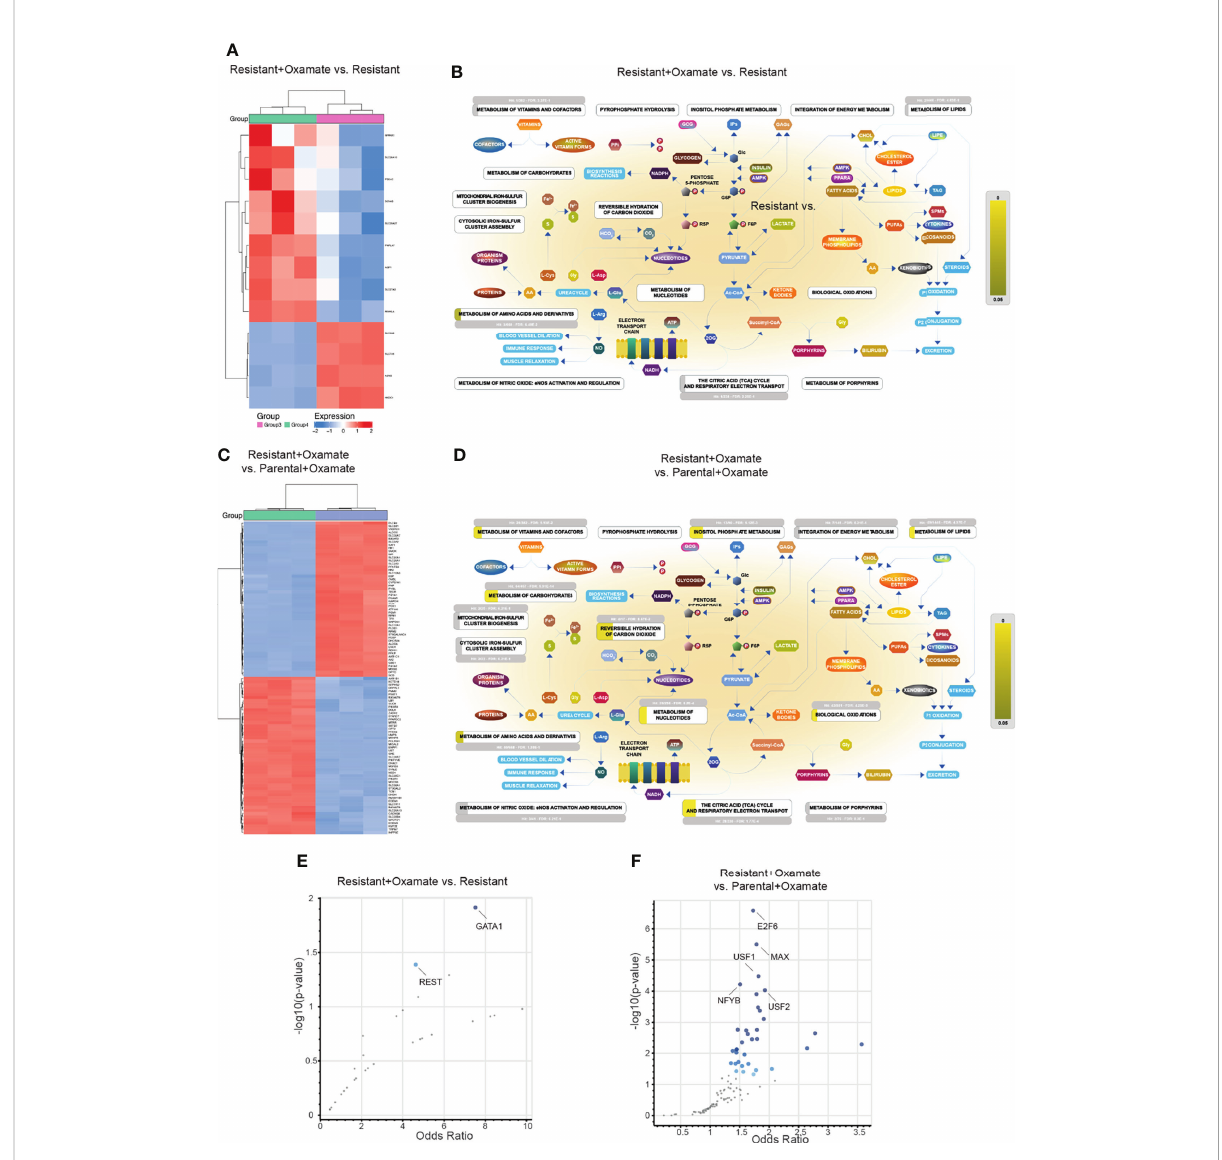
FIGURE 9 Alterations in metabolic genes and their potential transcriptional regulators in resistant/oxamate-treated resistant cells and oxamate-treated parental/oxamate-treated resistant cells. (A) Heatmap showing the expression of the top 100 (50 upregulated and 50 downregulated) differentially expressed metabolic genes between vehicle- and oxamate-treated oxamate-resistant MIAPaCa2 cells. (B) Reactome Pathway Analysis for differentially expressed metabolic genes between vehicle- and oxamate-treated oxamate-resistant MIAPaCa2 cells shows key metabolic pathways associated with signi fi cantly enriched genes (p-value <0.05, shown in yellow). (C) Heatmap showing the expression of the top 100 (50 upregulated and 50 downregulated) differentially expressed metabolic genes between oxamate-treated parental and oxamate- treated oxamate-resistant MIAPaCa2 cells. (D) Reactome Pathway Analysis for differentially expressed metabolic genes between oxamate- treated parental and oxamate-treated oxamate-resistant MIAPaCa2 cells cells shows key metabolic pathways associated with signi fi cantly enriched genes (p-value <0.05, shown in yellow). (E) Enrichr analysis using ENCODE and ChEA for identifying potential regulatory transcription factors involved in the differential expression of metabolic genes between vehicle- and oxamate-treated oxamate-resistant cells. (F) Enrichr analysis using ENCODE and ChEA for identifying potential regulatory transcription factors involved in the differential expression of metabolic genes between oxamate-treated parental and oxamate-treated oxamate-resistant MIAPaCa2